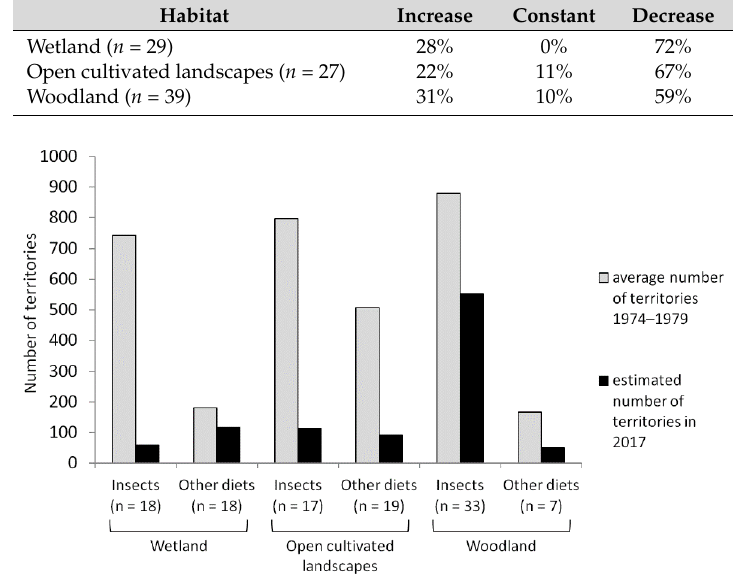
Figure 3. Number of territories across species at “Lampertheimer Altrhein” between 1974 and 1979 (average values) and in 2017 grouped by habitat and main food source. The values for 2017 were extrapolated to the size of the study area in